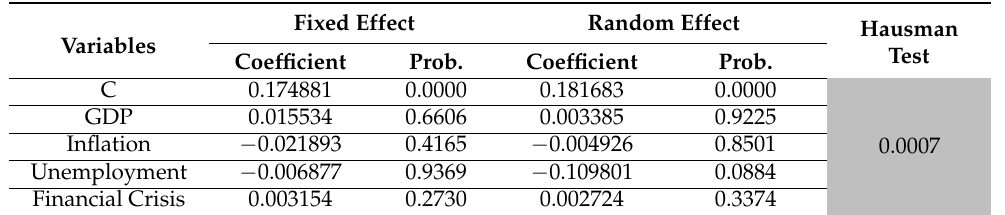
Table A2. The results of the Hausman Test for Country-specific Variables. The Hausman Specification test was carried out. The null and alternative hypotheses were as follows. Ho: Random-effects model is appropriate; H1: Fixed-effects model is appropriate.